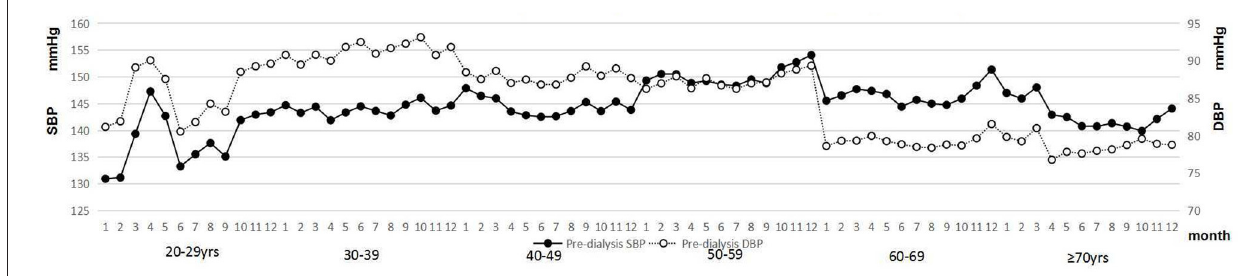
FIGURE 7 | Pre-dialysis blood pressure in different ages on a monthly basis.